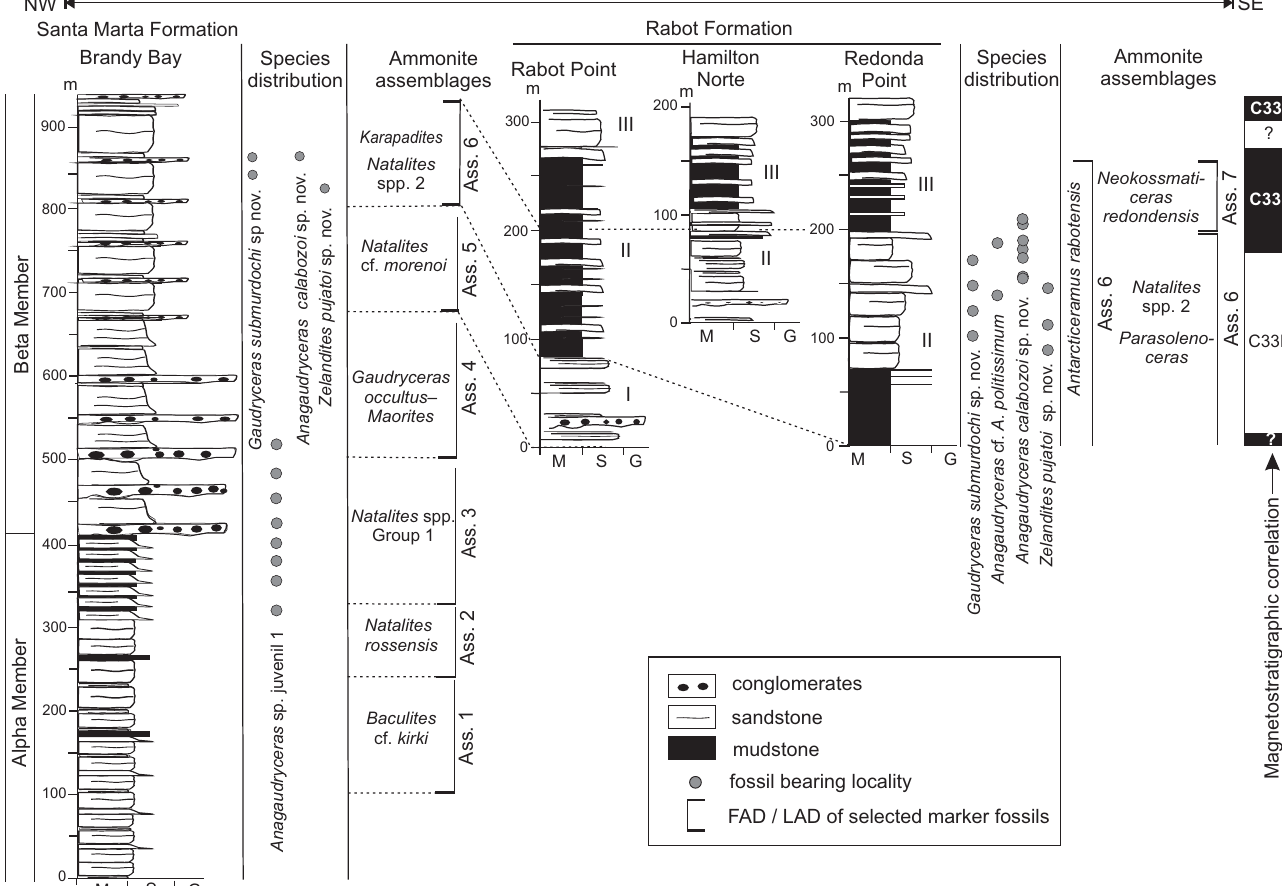
Fig. 2. Biostratigraphy of lytoceratid ammonites from the Santa Marta and Rabot formations, James Ross Island, early–mid-Campanian. Ammonite assemblages by Olivero (2012b), magnetostratigraphic correlation by Milanese et al. (2017a, b). Abbreviations: Ass., ammonite assemblage; G, gravel; I–III, informal names of the members of the Rabot Formation; M, mud; S, sand.